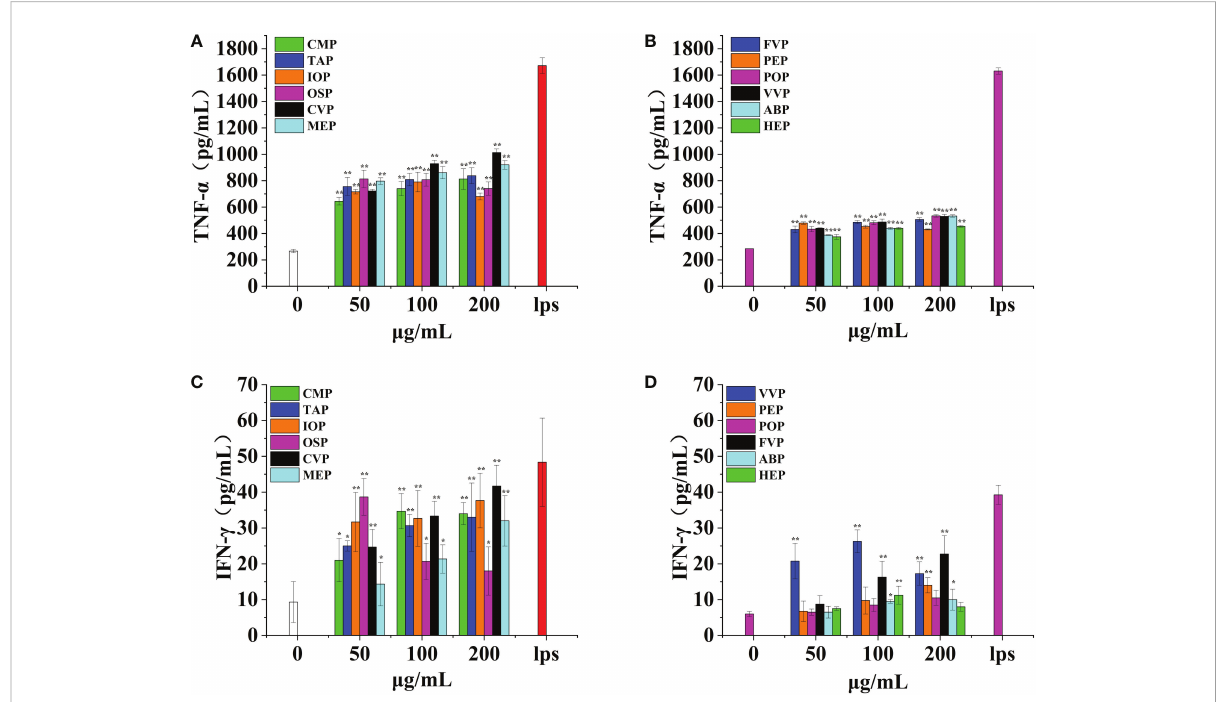
FIGURE 10 Effect of six rare edible mushrooms on TNF- a production in RAW 264.7 macrophages (A) . Effect of six common edible bacteria on TNF- a production in RAW 264.7 macrophages (B) , Effect of six rare edible bacteria on IFN- g production in RAW 264.7 macrophages (C) , Effect of six common edible bacteria on IFN- g production in RAW 264.7 macrophages (D) . *p < 0.05, **p < 0.01 indicates statistically signi fi cant difference compared to positive control